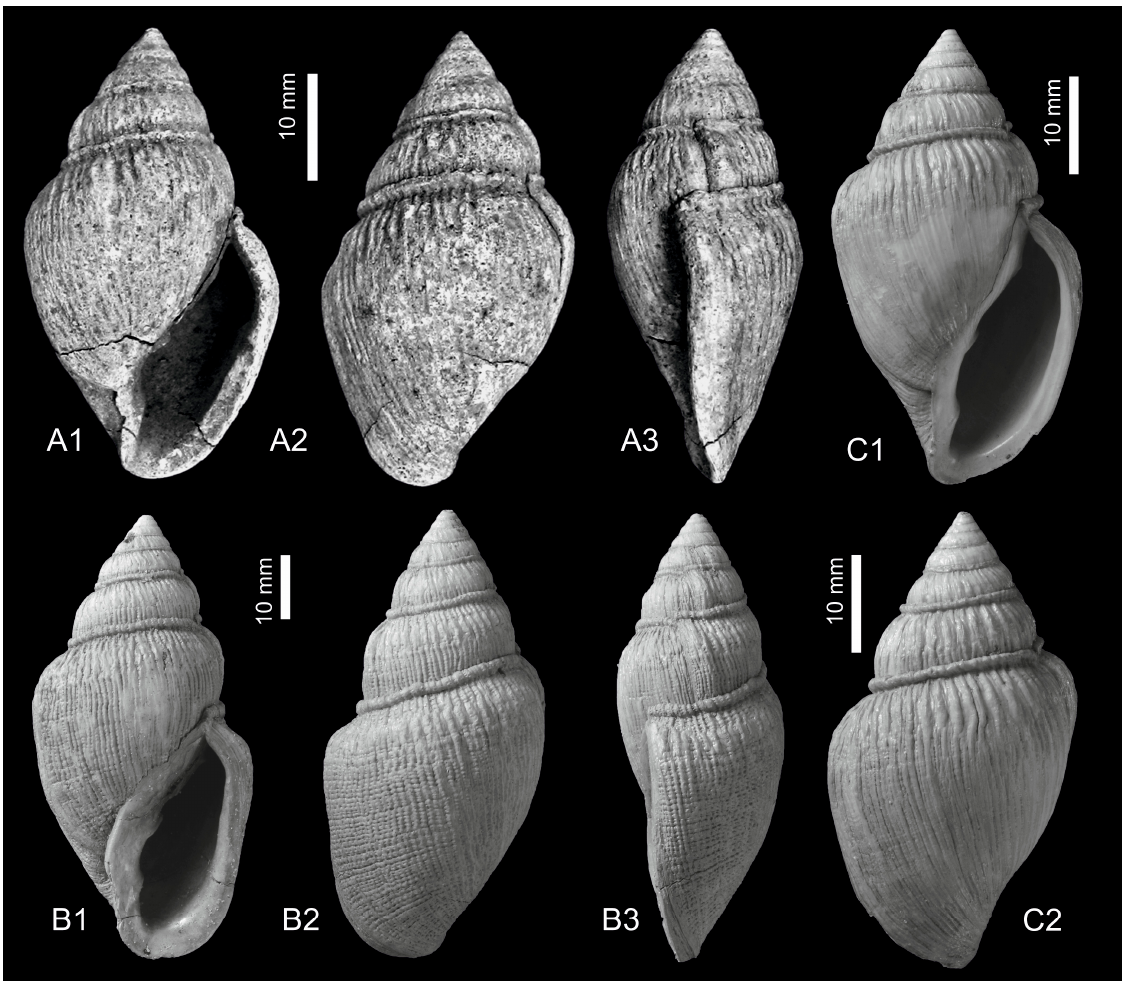
Figure 2. ( A1 – A3 ) Eoellobium heberti (Vasseur, 1881), lectotype MNHN.F.J04020 (Vasseur coll.) designated herein, Bartonian (Middle Eocene), Bartonian; Bois-Goüet at Saffré, Loire-Atlantique, France; ( A1 ) apertural view, ( A2 ) dorsal view, ( A3 ) lateral view; ( B1 – B3 ) MNHN.F.A87734 (Pacaud coll.), Bartonian (Middle Eocene), Bartonian; Bois-Goüet at Saffré, Loire-Atlantique, France, ( B1 ) apertural view, ( B2 ) dorsal view, ( B3 ) lateral view; ( C1 , C2 ) MNHN.F.A87733 (Pacaud coll.), Bartonian (Middle Eocene), Bartonian; Bois-Goüet at Saffr é , Loire-Atlantique, France, ( C1 ) apertural view, ( C2 ) dorsal